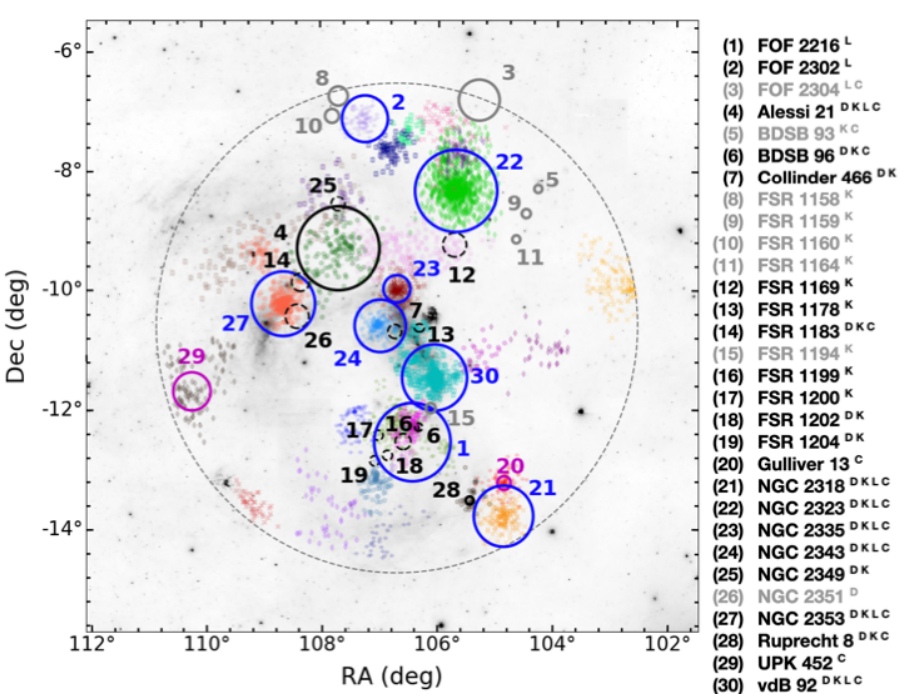
Figure 6. Stellar groups and clusters identified by Santos-Silva et al. [170] in Cep OB3. The labelled groupings are those that the authors reported to be listed in various catalogues in the literature. Reproduced from Santos-Silva et al. [170] with the permission of the